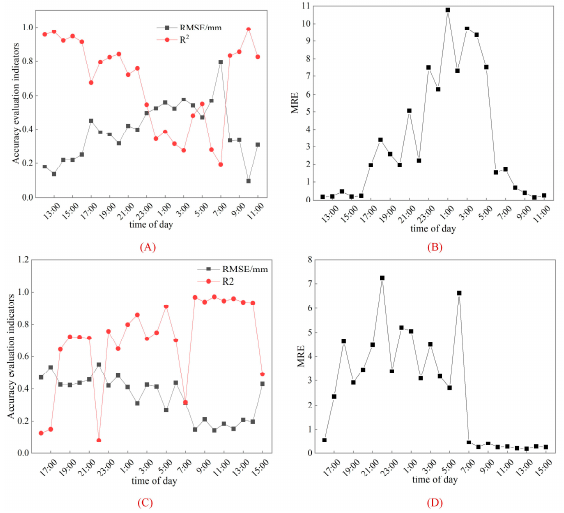
Figure 10. Comparison of accuracy of CNN inversion of OFT at different times: ( A ) RMSE and R 2 in summer; ( B ) MRE in summer; ( C ) RMSE and R 2 in autumn; ( D ) MRE in autumn.